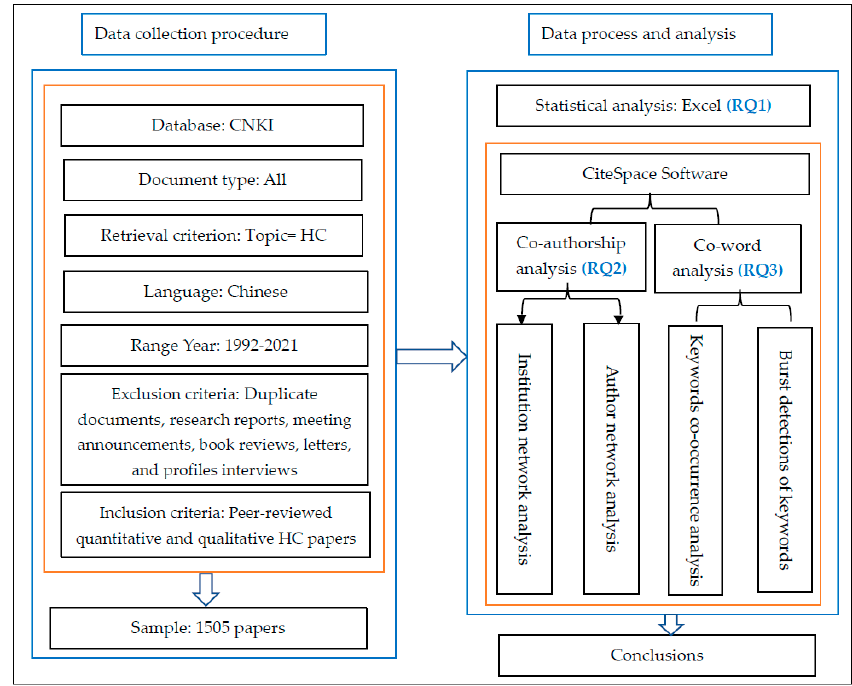
Figure 1. The integrated analysis framework.